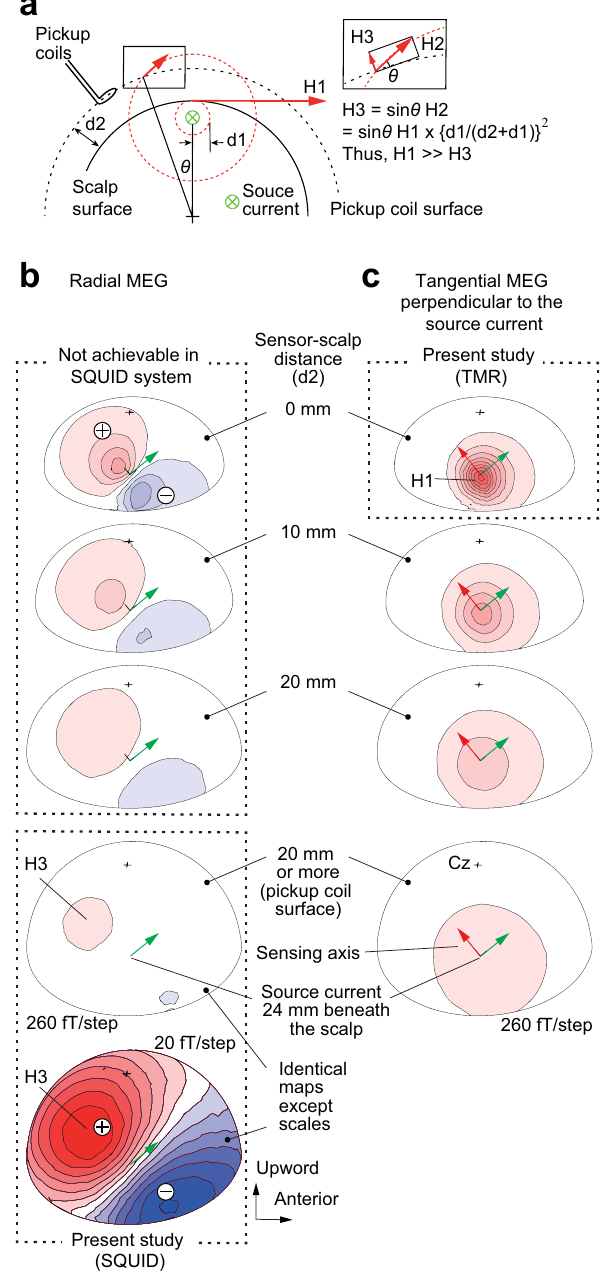
Figure 2. Advantages of scalp-attached tangential MEG. ( a ) Schema to explain the difference in amplitude maxima between scalp-attached tangential MEG measured by TMR sensors (H1), unmeasured oblique MEG (H2), and scalp radial MEG measured at the pickup coil surface of SQUID (H3). Note the H1 amplitude is much larger than H3 under the Bio-Savart law showing the magnetic field generated by a current is negatively correlated to the square of source-sensor distance (d1 for H1 and d1 + d2 for H2). ( b ) Right parietal view of simulated isofield maps of radial MEG at 4 different setback distances between the sensors and the scalp. A current source positioned 24 mm beneath the scalp simulating the N20m response after the left median nerve stimulation demonstrated in the present study. Note the clear dipole patterns of short inter-peak distances between magnetic influx and outflux, measured at 0, 10, and 20 mm above the scalp, are not achievable with superconducting MEG due to the wall thickness of the Dewar vessel containing liquid helium. ( c ) Simulation of tangential MEG maps when measured perpendicularly to the source current. Note the largest and steepest peak on the scalp immediately above the source (H1) proved in the present